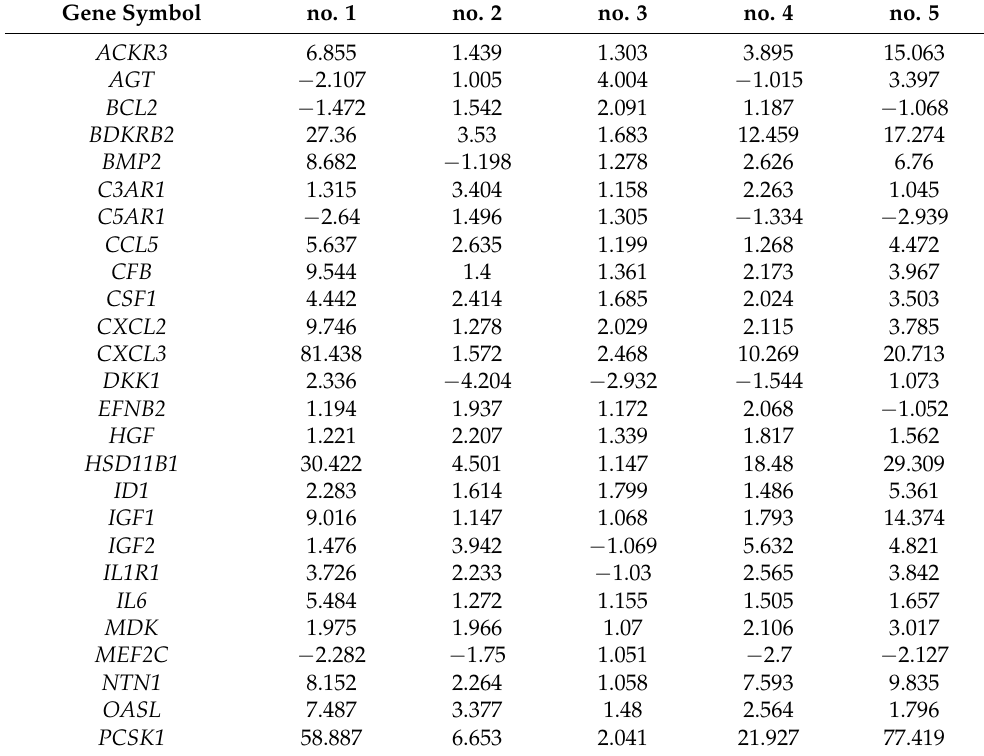
Table 2. Expression log2 fold change values of 38 genes related to osteoblasts, osteoclasts, bone remodeling, osteoporosis, and sarcopenia in mesenchymal stromal cells from participants in the control group based on RNA-sequencing